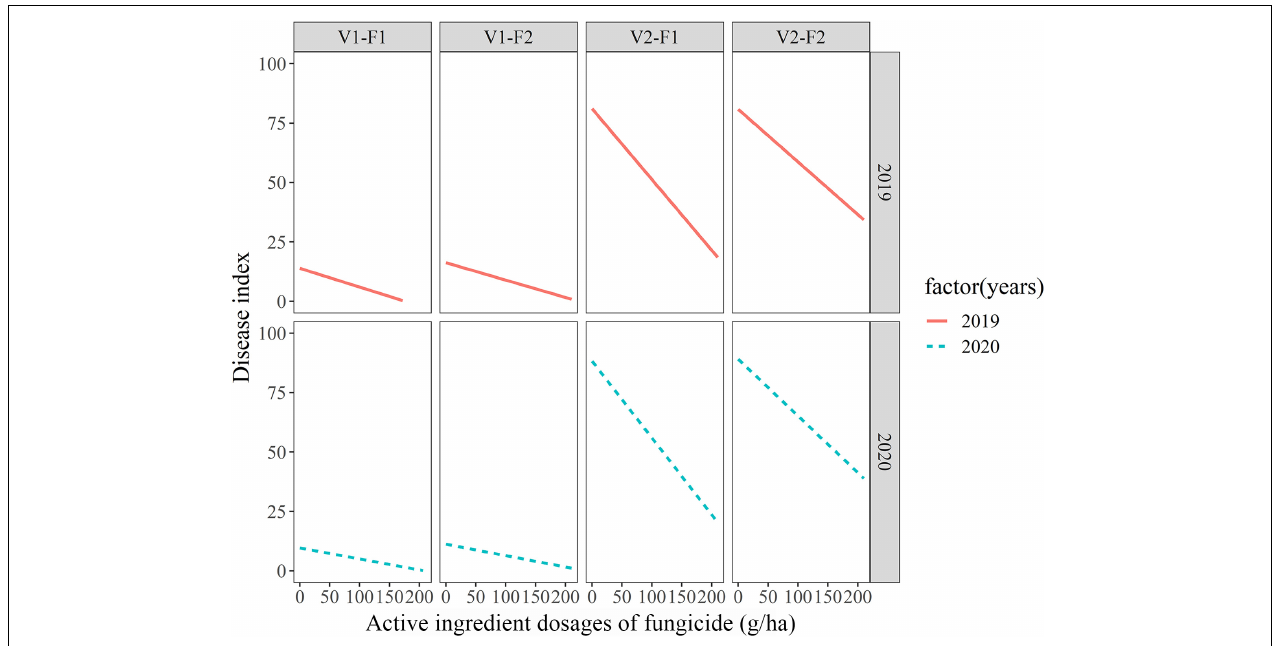
FIGURE 1 | Fitted random-coefficient models relating active ingredient dosages of fungicides to wheat powdery mildew index among different variety-fungicide-year combinations. F1 and F2 represent enostroburin · epoxiconazole 18% SC and triadimefon 20% EC, respectively; V1 and V2 represent highly resistant variety (“Baofeng104”) and highly susceptible variety (“Jingshuang16”), respectively.